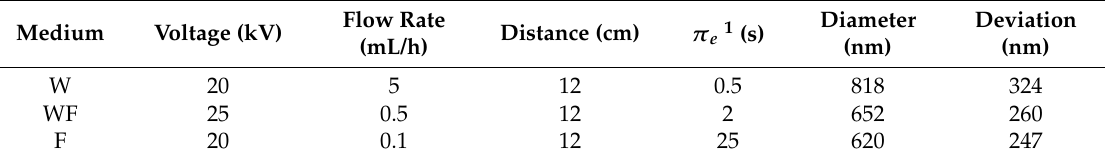
Table 1. Optimal parameters and derived fiber morphologies for the electrospinning of PEG in the three studied